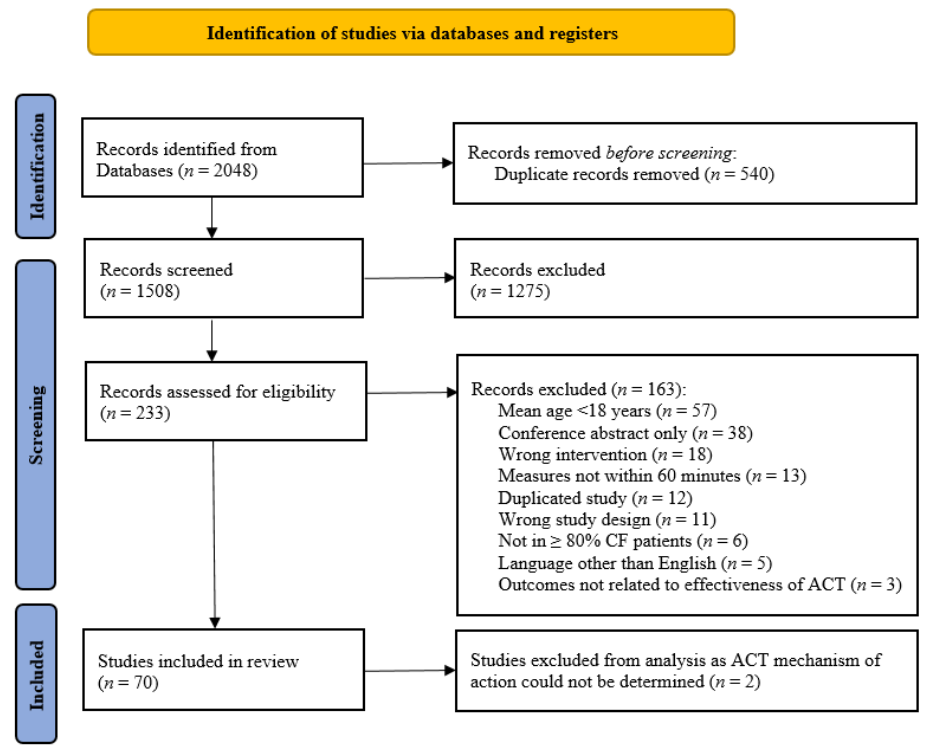
Figure 1. PRISMA study flow diagram [21] .